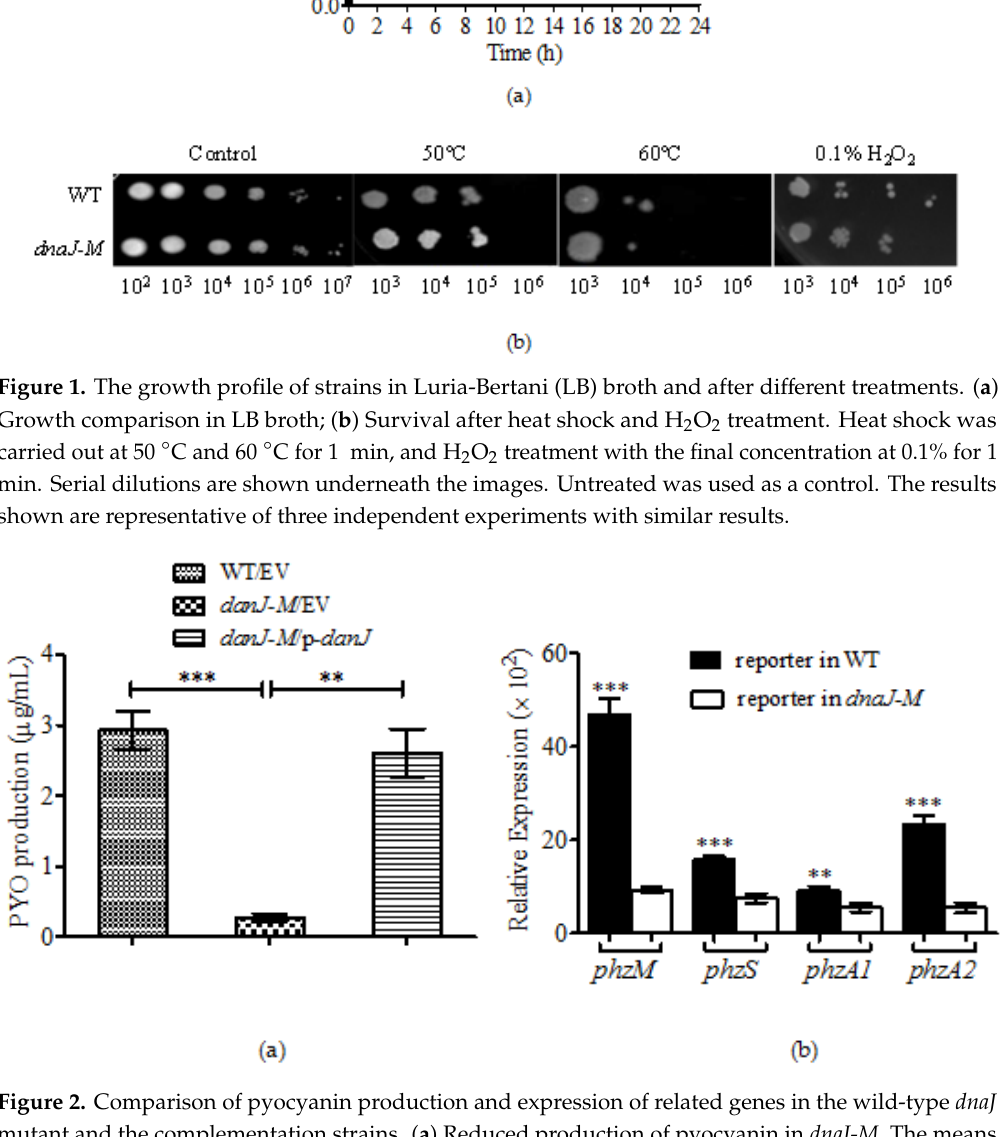
Figure 1. The growth profile of strains in Luria-Bertani (LB) broth and after different treatments. ( a ) Growth comparison in LB broth; ( b ) Survival after heat shock and H 2 O 2 treatment. Heat shock was carried out at 50 °C and 60 °C for 1 min, and H 2 O 2 treatment with the final concentration at 0.1% for 1 min. Serial dilutions are shown underneath the images. Untreated was used as a control. The results shown are representative of three independent experiments with similar results.